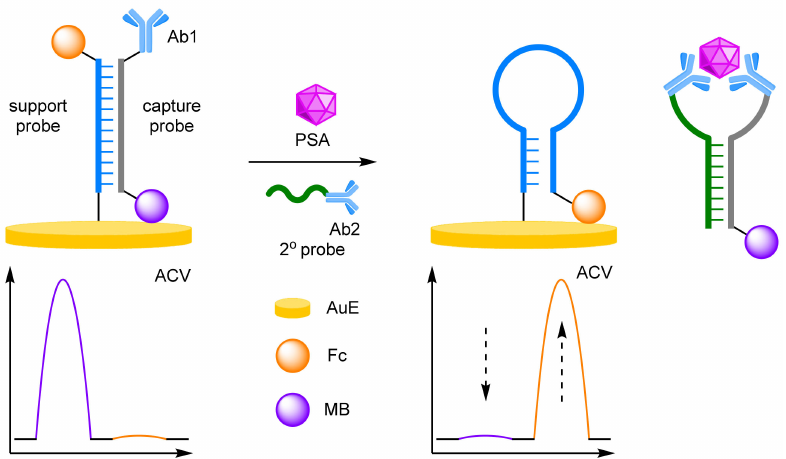
Figure 4. Schematic representation of an antibody-based biosensor for the detection of protein-specific antigen